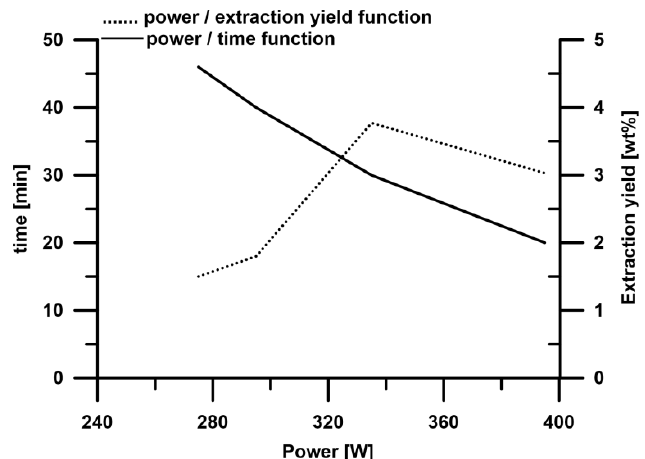
Figure 3. The influence of microwave power on the extraction time (––––) and the extraction yield (……….).